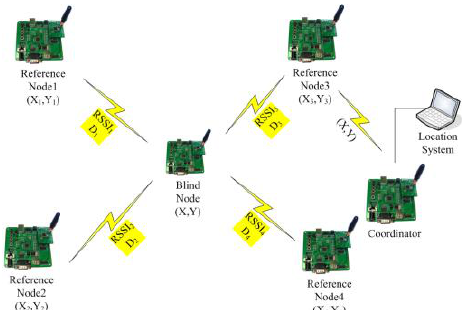
Figure 2. A scenario of the ZPS scheme for estimating the BN’s location based on the RSSI